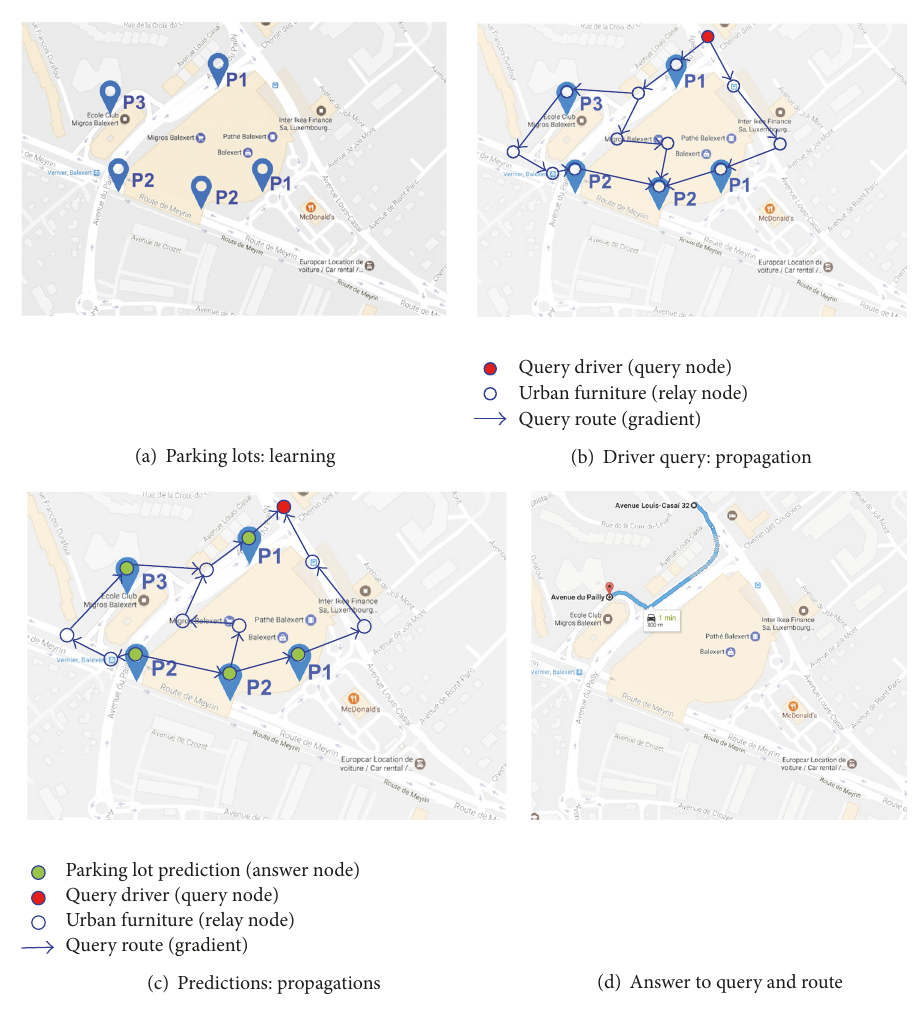
Figure 1: Driver query, prediction propagations, and